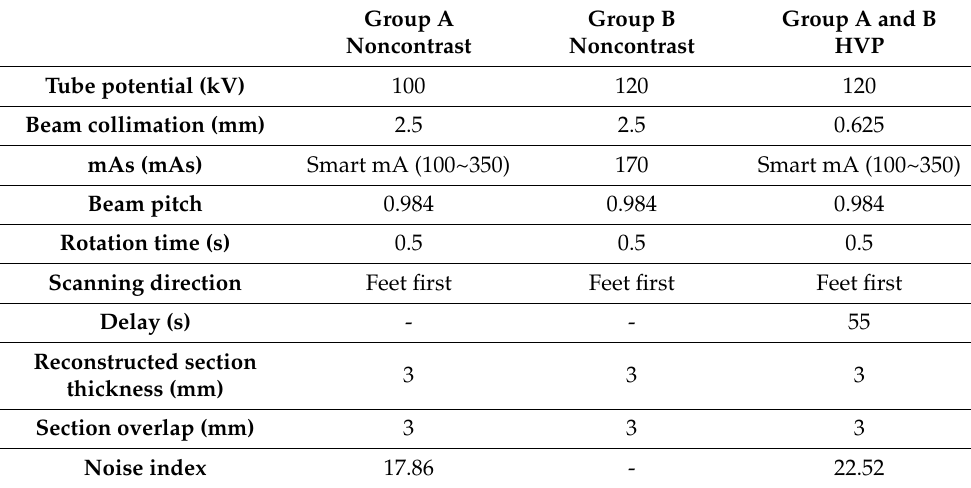
Table 1. Abdominal noncontrast and HVP CT scan parameters for groups A and